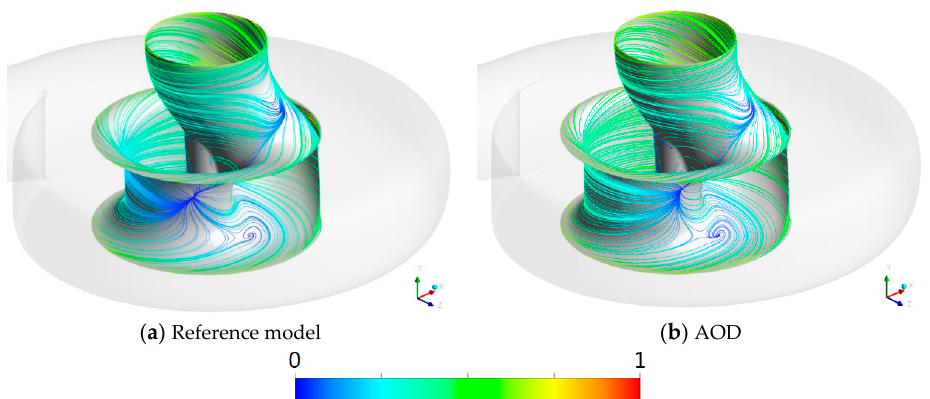
Figure 13. Time-averaged pressure contours on impeller surface wall.